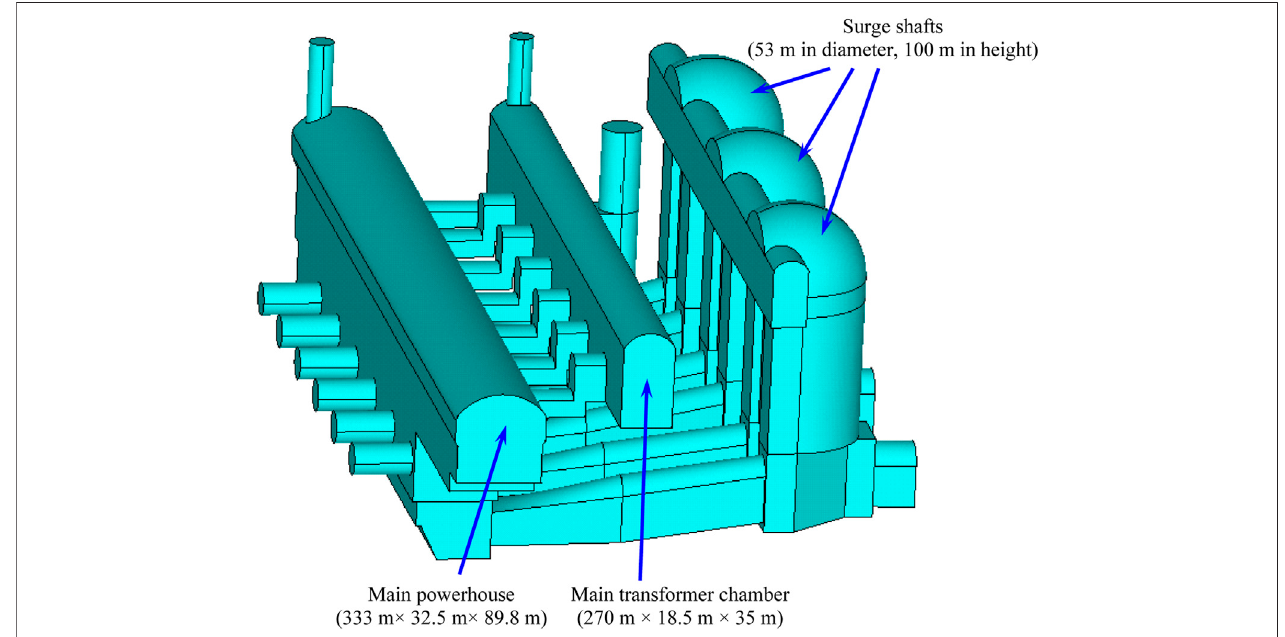
FIGURE 1 | Overview of the Wudongde underground